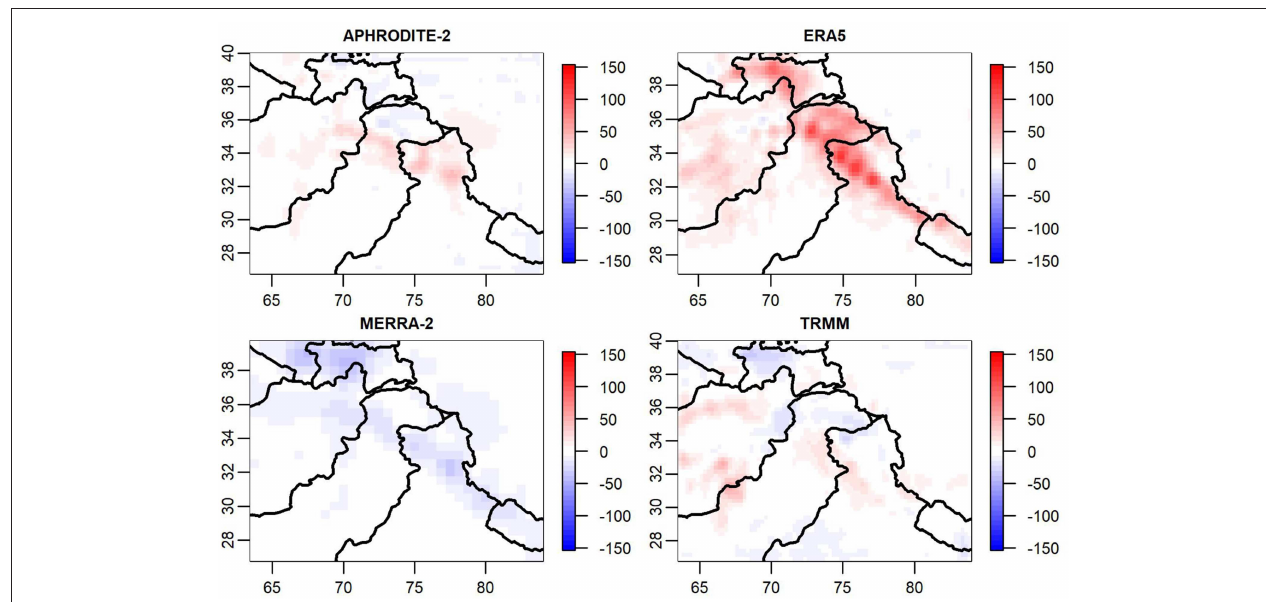
FIGURE 8 | Averaged discrepancies (in mm) for the months of December, January, and February across 10 years.